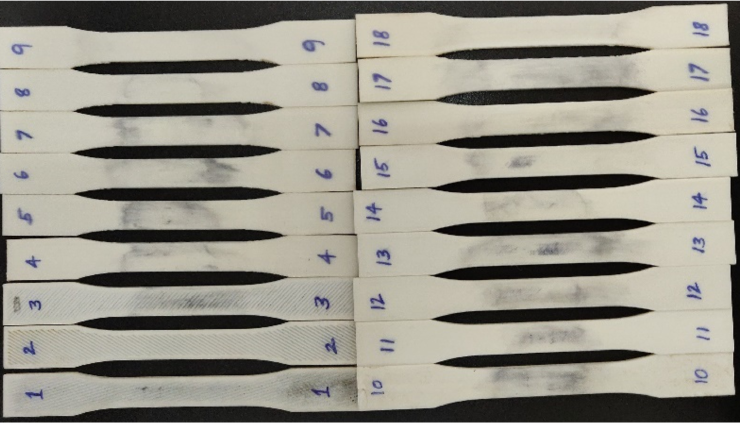
Figure 6. ASTM D638 specimen for tensile testing (all dimensions are in mm) [22].